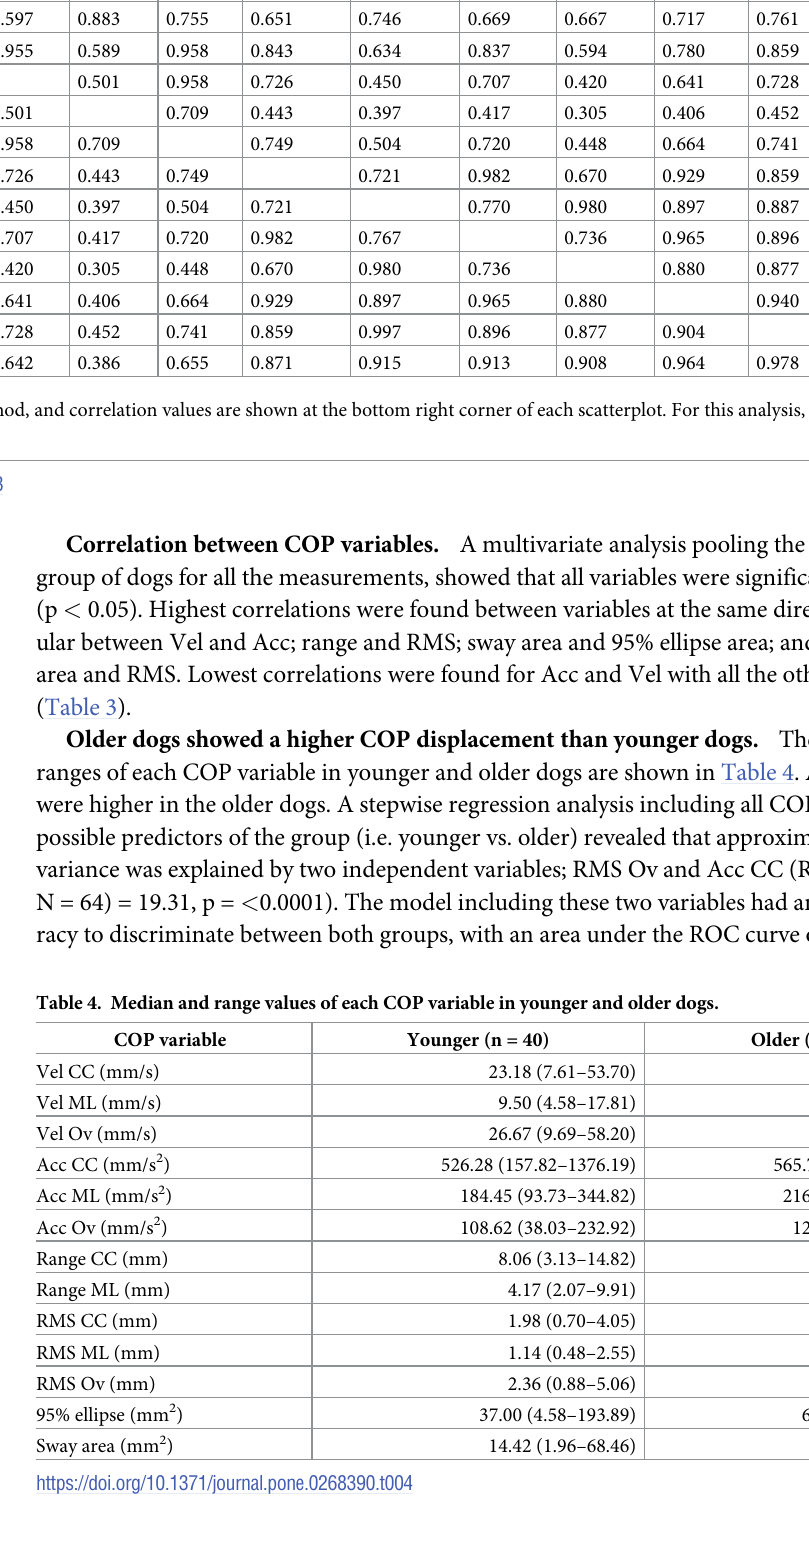
Table 3. Multivariate analysis showing correlations between COP measurements in all dogs.